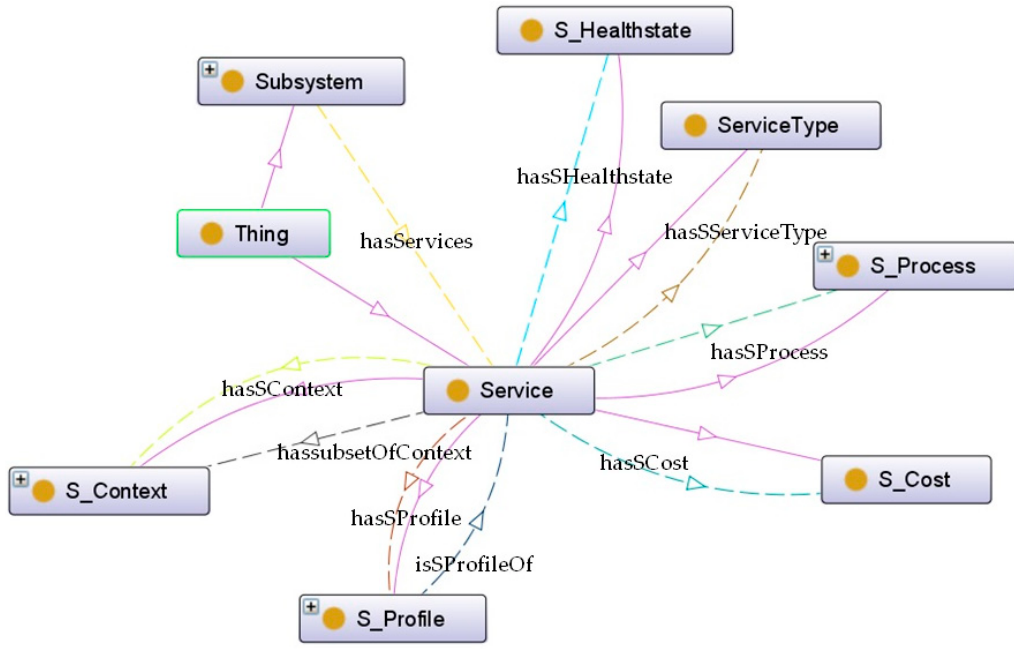
Figure 6. Top Level hierarchy of Service.